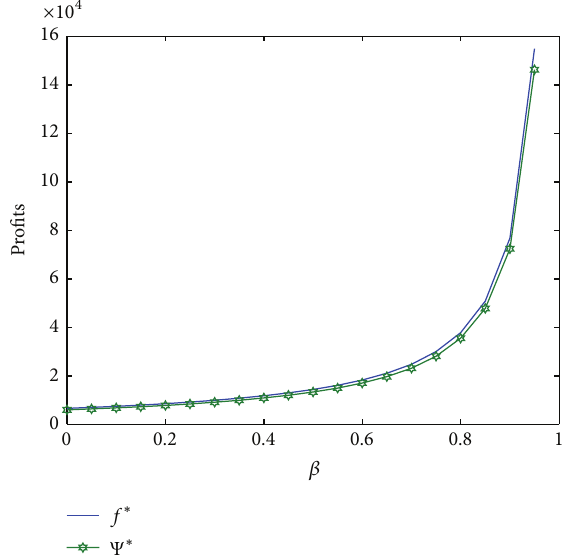
Figure 17: Impact of 𝛽 on the profits under demand certainty and